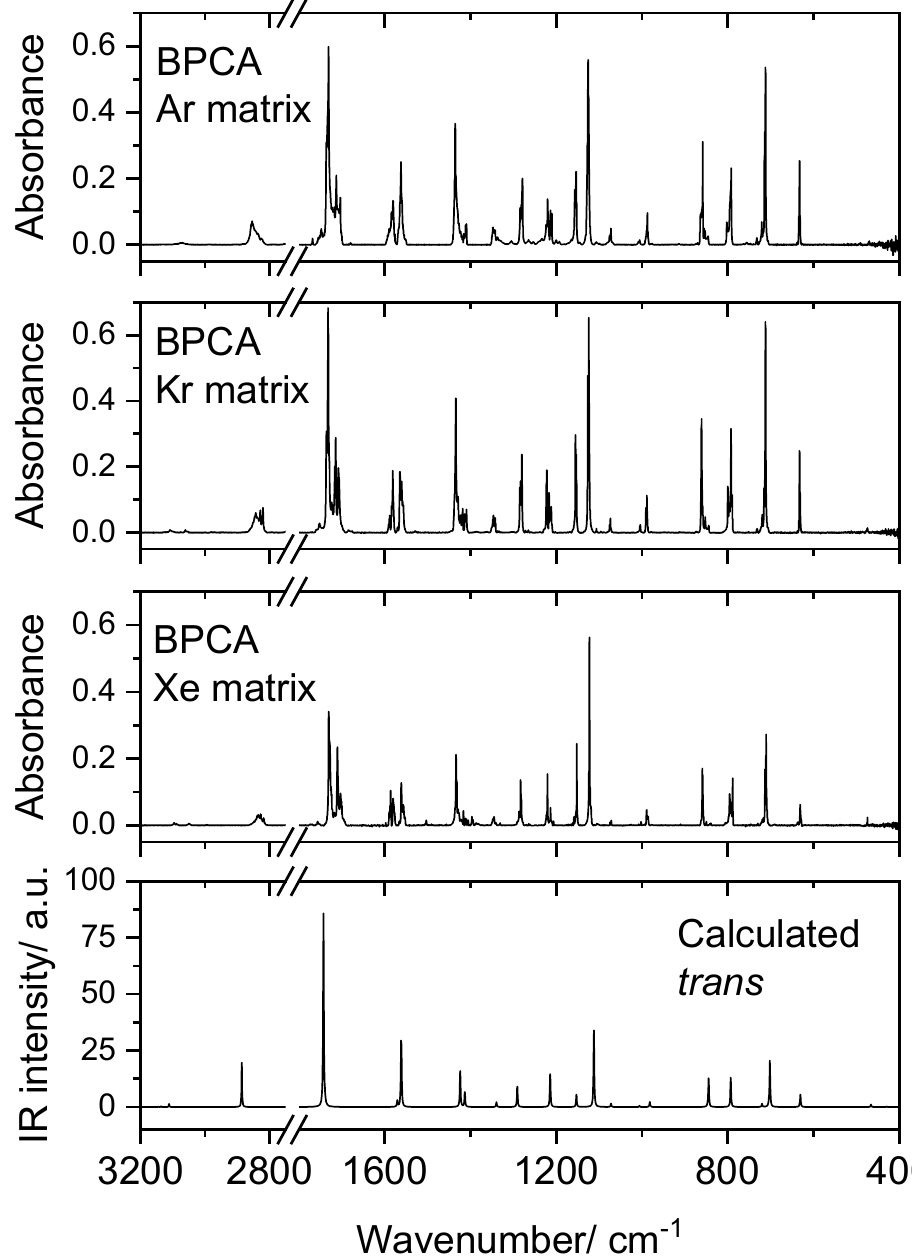
Figure 2. Experimental IR spectra of BPCA isolated in Ar, Kr and Xe matrices (15 K), and simulated IR spectrum of the trans conformer of the molecule, built using the B3LYP/6-311++G(d,p) calculated vibrational data (frequencies were scaled as described in Section 3).